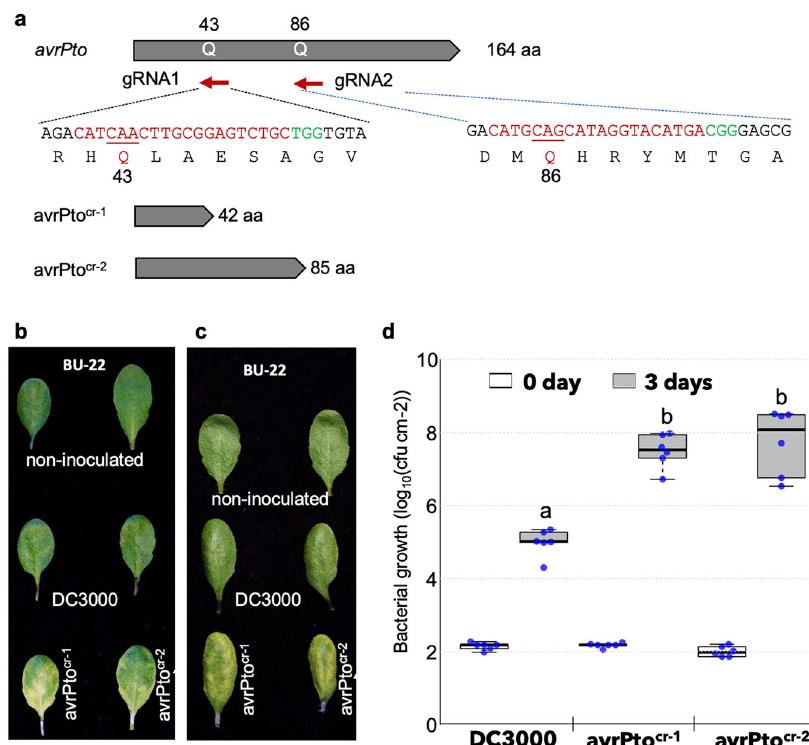
Fig. 3 Base editing of avrPto in Pst DC3000. a Schematic of avrPto and the CRISPR deletions caused by guide RNAs, gRNA1 and gRNA2, resulting in avrPto cr-1 and avrPto cr-2 . b , c Replicated disease responses of Arabidopsis accession BU-22 when in fi ltrated at a bacterial density of 1 × 10 6 cfu/ml with DC3000 compared to decreased responses observed using avrPto cr-1 and avrPto cr-2 . d In planta bacterial growth assay in BU-22 in fi ltrated with DC3000, avrPto cr-1 or avrPto cr-2 at a bacterial density of 5 × 10 4 cfu/ml. Values represent averages from two independent experiments with triplicate samples. Boxes extend from 25th to 75th percentiles and display median values as center lines. Whiskers plot minimum and maximum values and individual data points. Three independent experiments each with triplicate samples were performed, and treatments with different lowercases are signi fi cantly different at